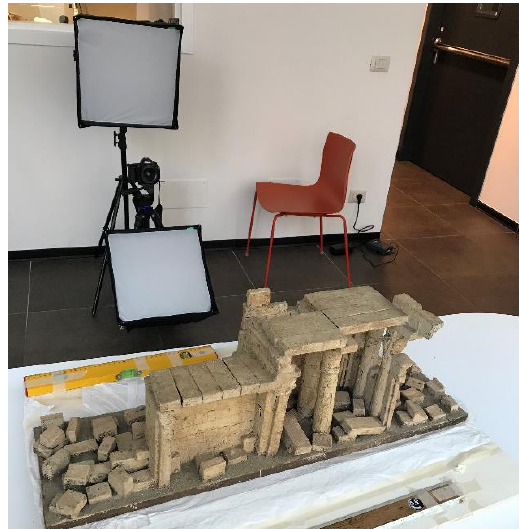
Figure 1. The Temple of El-Hilla during the photogrammetric set of acquisition